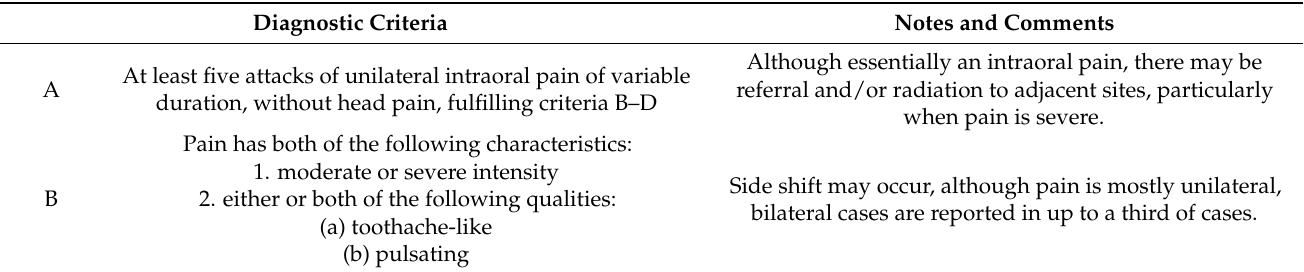
Table 3. Diagnostic Criteria for Neurovascular orofacial pain (NVOP). * (Adapted from [3]). Diagnostic